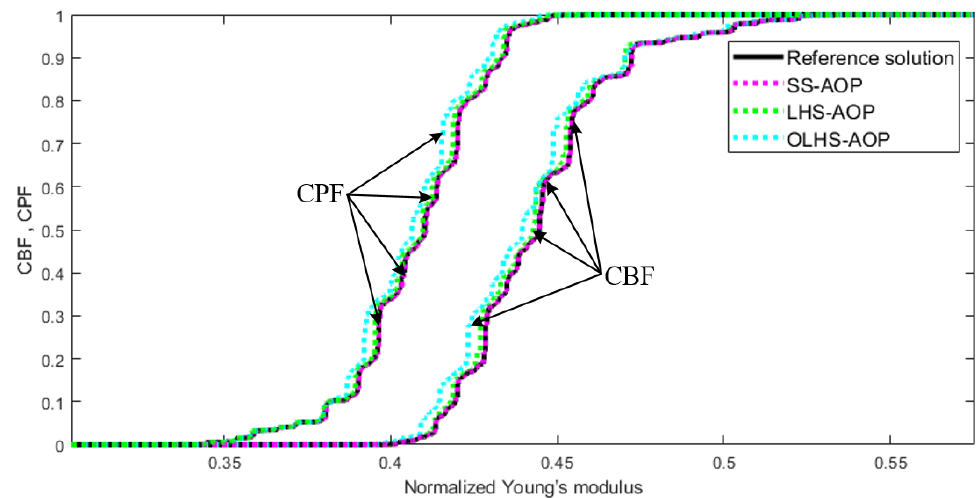
Figure 10. The CBF and CPF of the double-V NPR structure responses obtained with 5 focal elements for different